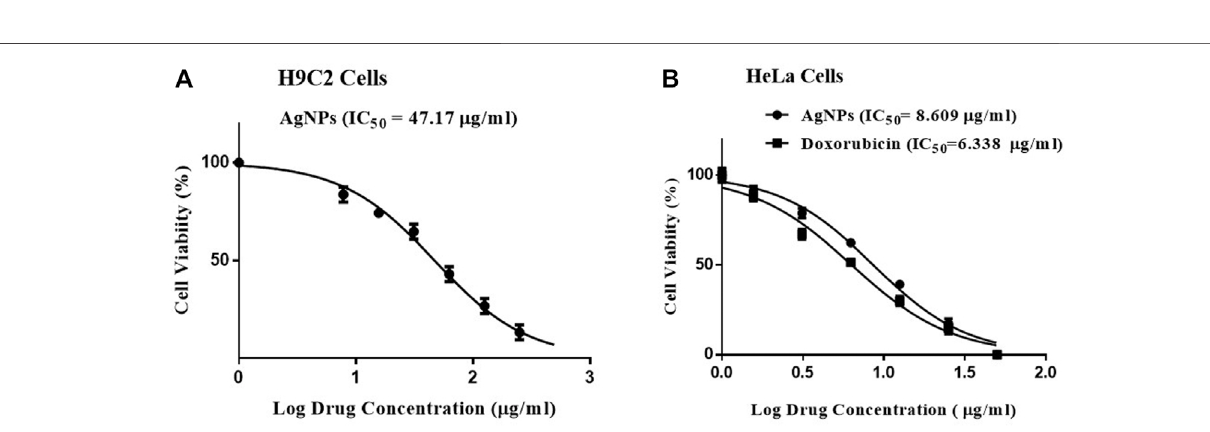
Frontiers in Pharmacology |